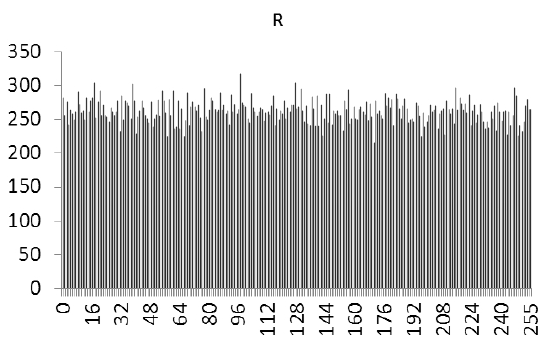
Figure 29. Statistical chart of R value distribution after encryption.